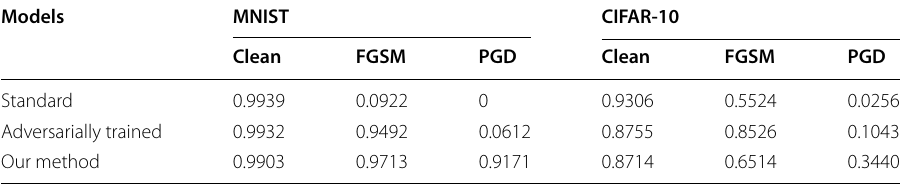
Table 4 Test accuracies showing the impact of adversarial training, clean refers to the original testing data, FGSM refers to adversary examples derived from Fast Gradient Sign Method and PGD refers to adversarial examples derived from